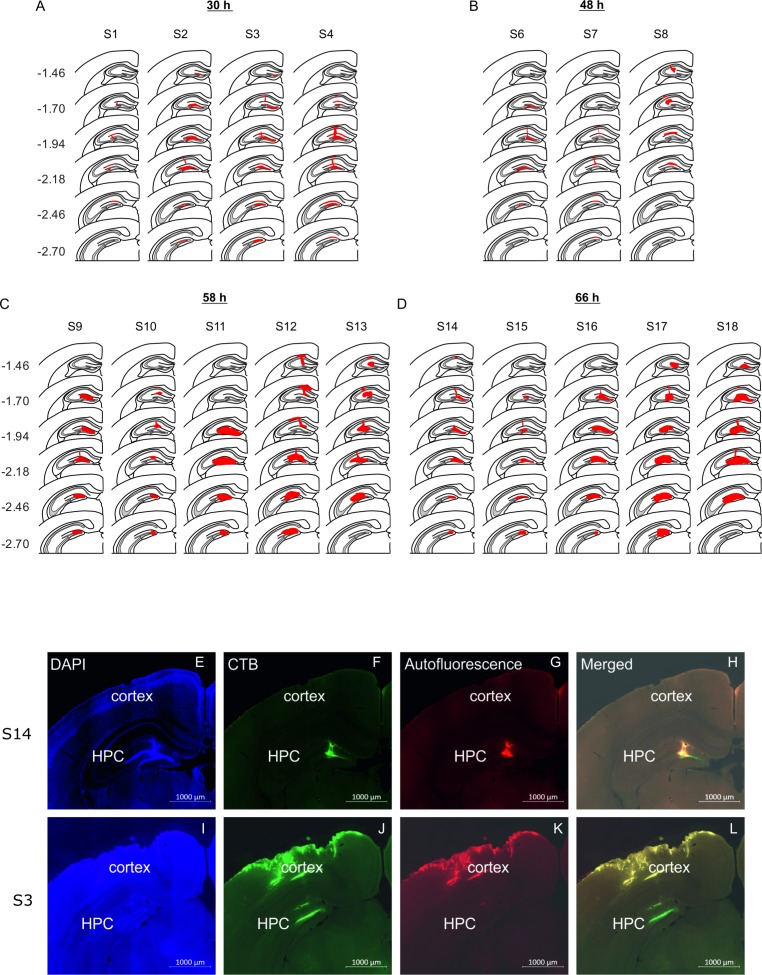
Location of rabies virus injections for the four experimental groups.RABV was co-injected with fluorescent CTB to visualize the injection spread. (A-D) The location of the injection is indicated by the red area on a standard coronal outline of the left hippocampus for the 30 hr (A), the 48 hr (B), the 58 hr (C) and the 66 hr (D) survival time groups. Rostro-caudal position relative to bregma is indicated on the left (mm). Experimental ID for each case is shown above the sections. (E) Representative photomicrographs from two mice (S14 and S3) illustrating the spread of CTB used to define the site of rabies injection in the hippocampus.